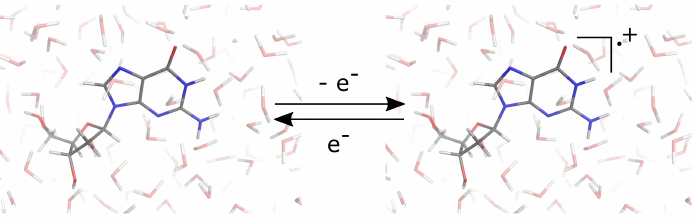
Figure 9. Schematic representation of the redox reaction of the neutral guanosine in aqueous